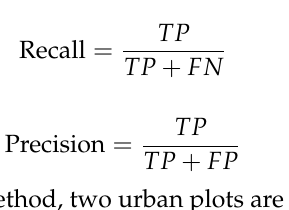
Figure 5. The feature extraction results of K- neighborhood and R- neighborhood of plot 2. ( a ) Char- acteristic of linearity of K -nearest neighbors; ( b ) Characteristic of planarity of K -nearest neighbors; ( c ) Characteristic of dispersion of K -nearest neighbors; ( d ) Characteristic of linearity of R -nearest neighbors; ( e ) Characteristic of planarity of R -nearest neighbors; ( f ) Characteristic of planarity of R - nearest neighbors.